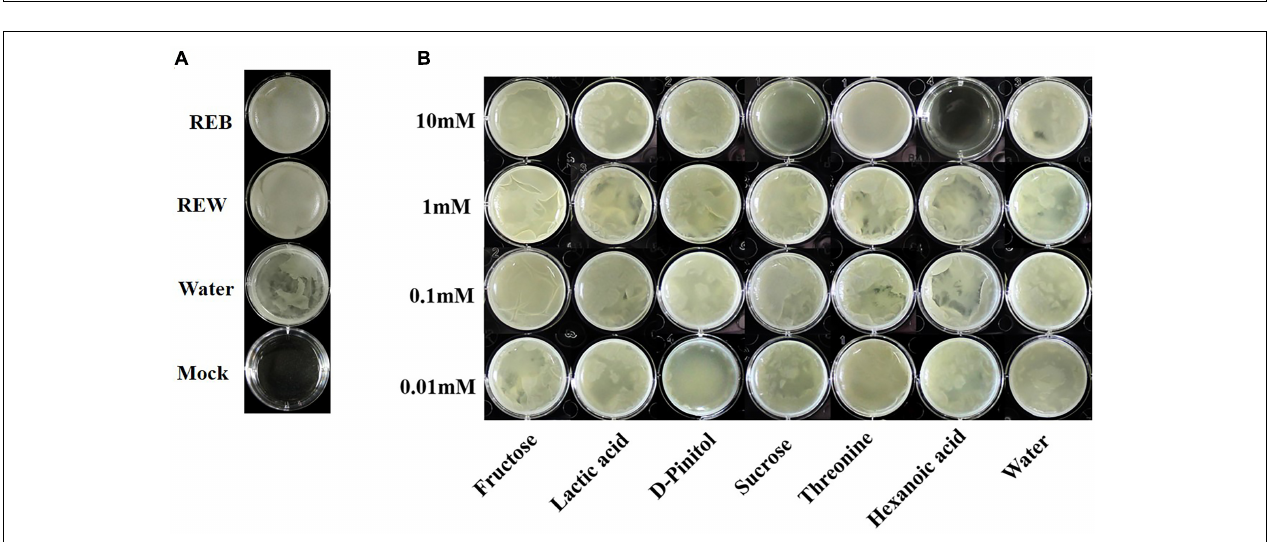
FIGURE 7 | Pellicle biofilm formation of Bacillus cereus AR156 in Luria-Bertan- Glycerol- Magnesium medium (LBGM) containing tomato root exudate induced by Bacillus cereus AR156 (REB), tomato root exudate induced by water (REW) (A) or different components from tomato root exudates induced by B. cereus AR156 (B) . The experiment was carried out three times and one representative experiment is